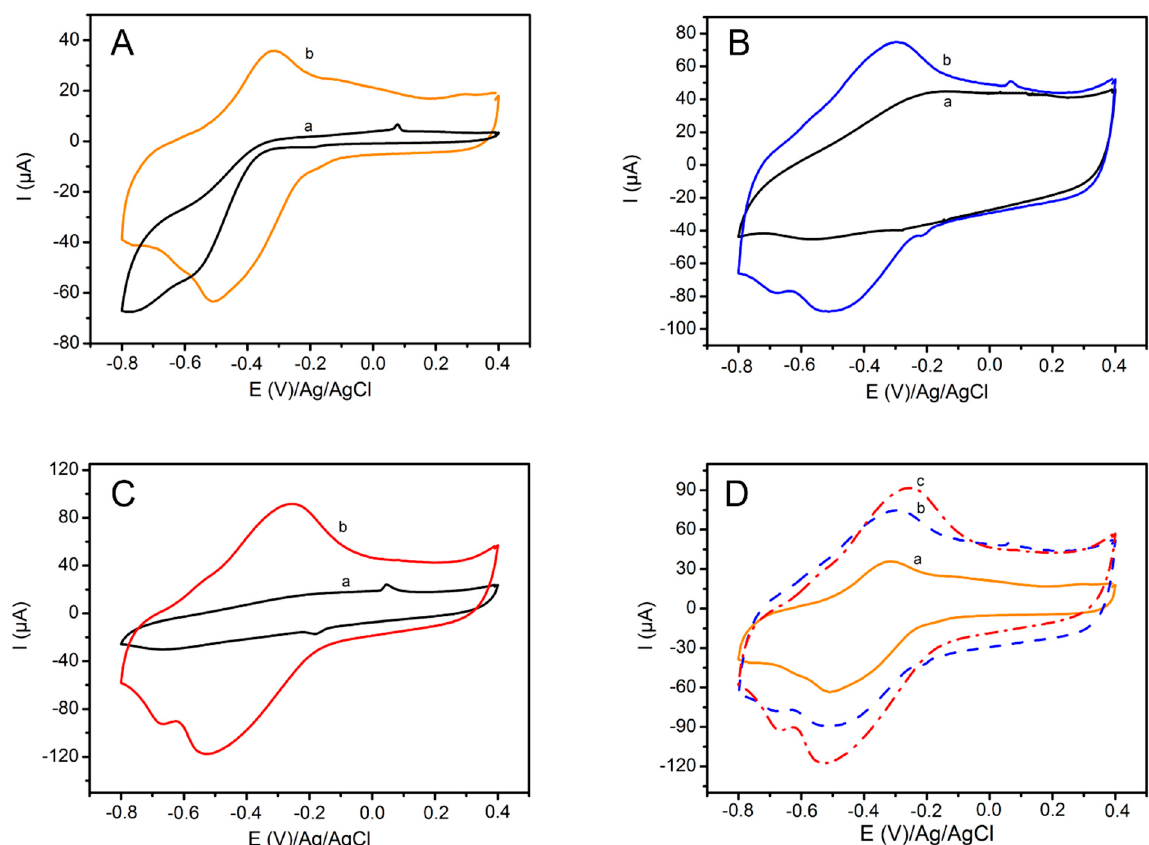
Figure 4. CVs recorded in 10 mM PBS pH 7.4 at scan rate 100 mV/s: ( A ) MoS2, ( B )/PPyNPs, ( C ) MoS2/PPyNPs; ( a ) before and ( b ) after NQ attachment); ( D ) CV comparing the three platforms after NQ attachment: ( a ) MoS2, ( b ) PPyNPs, and ( c ) MoS2/PPyNPs.